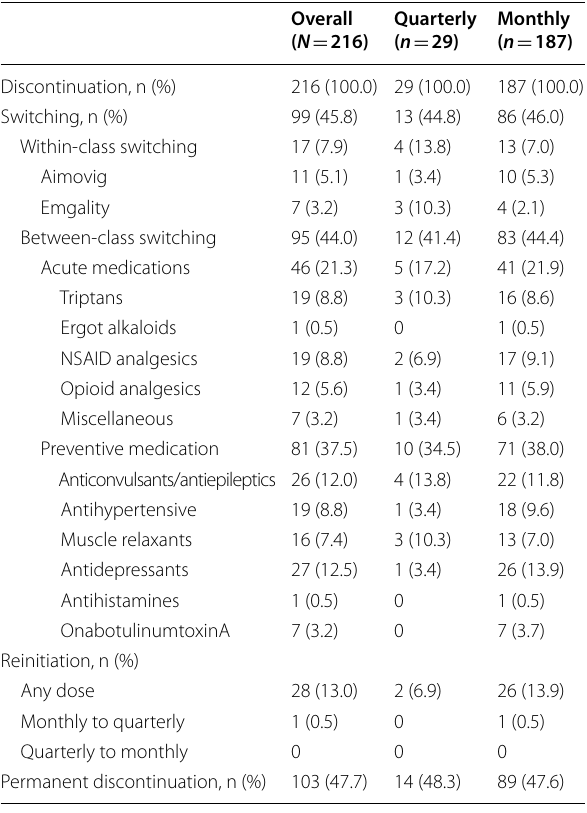
Table 2 Discontinuation rates of fremanezumab and subsequent medication